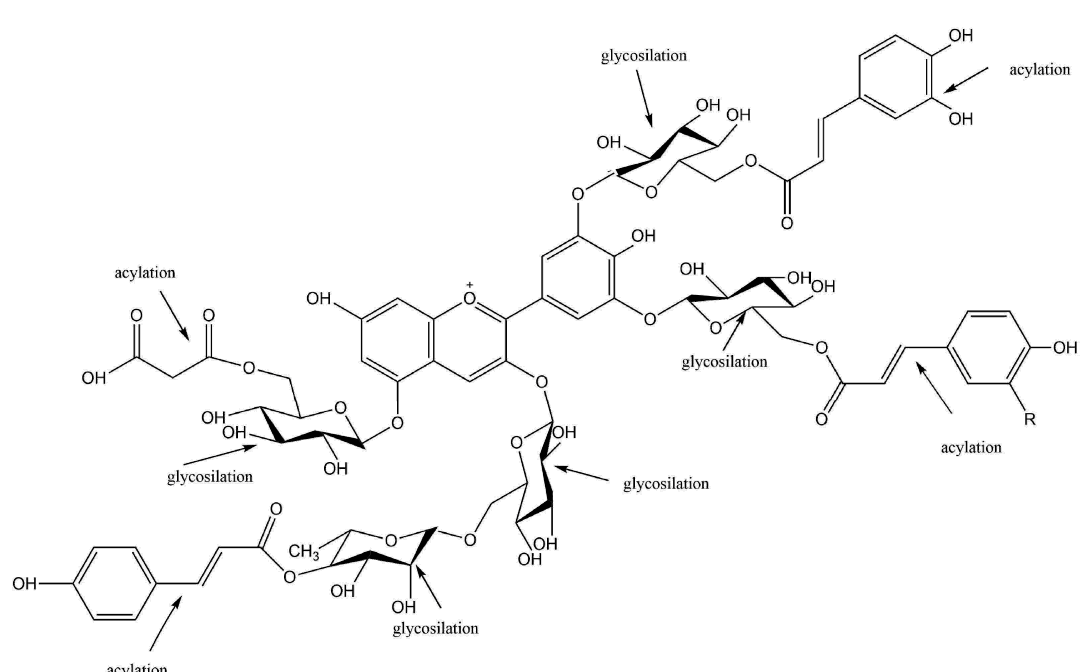
Figure 1. Typically glycosylation and acylation of anthocyanins (adapted from [25,26]). They present a characteristic chemical structure, having a carbon chain (C 6 —C 3 —C 6 ) where an